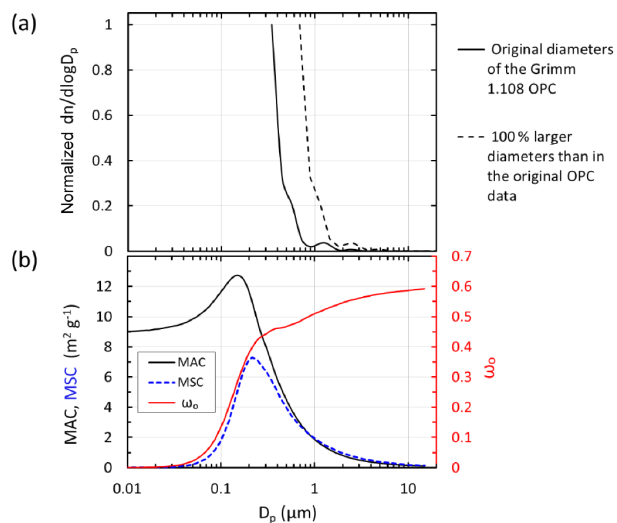
Figure 2. Size-dependent aerosol properties relevant to the exper- iment. (a) Normalized average particle number size distribution of soot aerosol measurement in the mixing chamber with the Grimm 1.108 OPC. The continuous lines present the size distributions with the original diameters of the OPC, and the dashed lines show those assuming that the original diameters were underestimated by a fac- tor of 2. (b) Mass absorption and scattering coefficients, MAC and MSC, respectively, and single-scattering albedo ω o of single BC particles at λ =